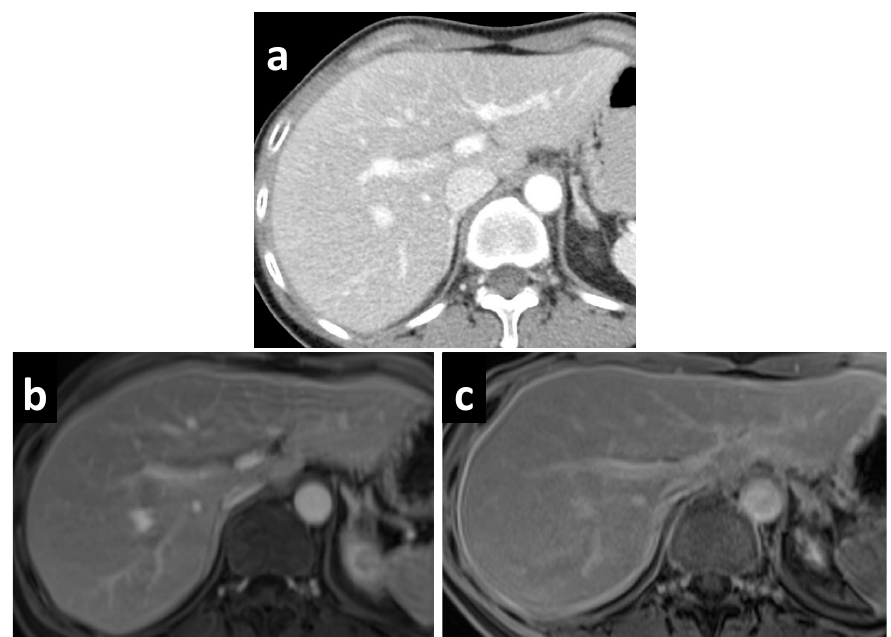
Figure 4. A 55-year-old female with PMP. ( a ) CT reveals no significant abnormality, but MRI per- formed on the same day demonstrates a thin enhancing line surrounding the liver on the ( b ) portal venous phase, which becomes more apparent on the ( c ) delayed phase.